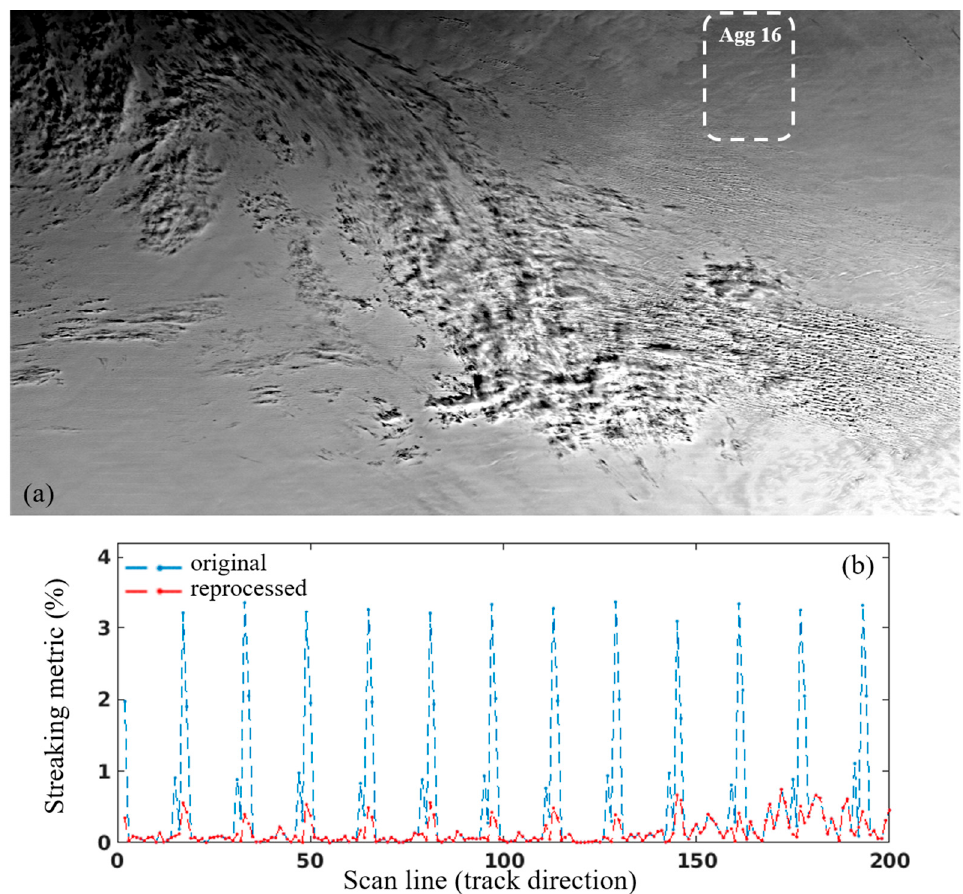
Figure 10. ( a ) Reprocessed NOAA-20 VIIRS DNB daytime image recorded over Antarctica at 8:34 UTC, 14 December 2020. The 768 × 768 (track × scan) pixels are on the right side of the granule (aggregation zones 8–19). The updated NOAA-20 VIIRS DNB LGS Gains LUT was used for reprocessing. ( b ) Streaking metrics of the original (Figure 2a) and reprocessed (Figure 10a) radiance along the selected scan lines within aggregation zone 16 on the right side of the granule (white rectangular).